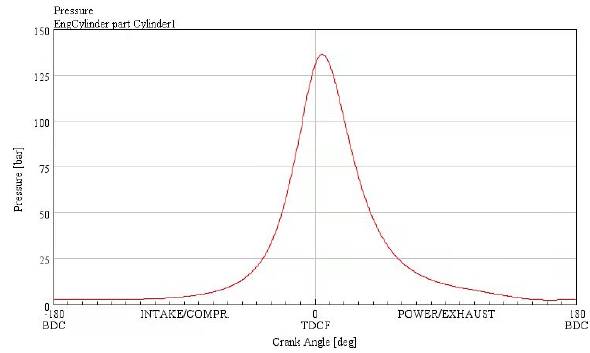
Figure 3. Explosion pressure curve in cylinder.